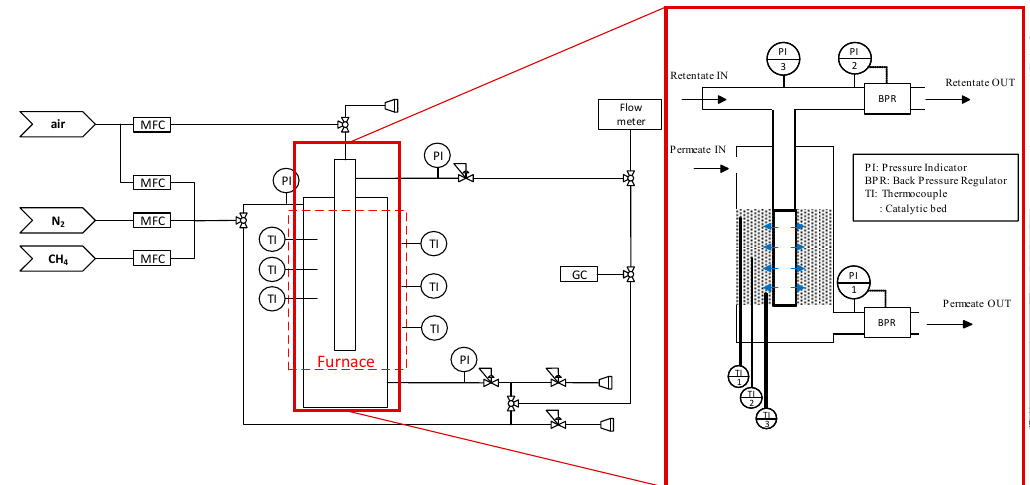
Figure 2. Scheme of the setup used for the experiments both with packed bed and packed bed membrane reactor configurations, with zoom-in to the reactor part.